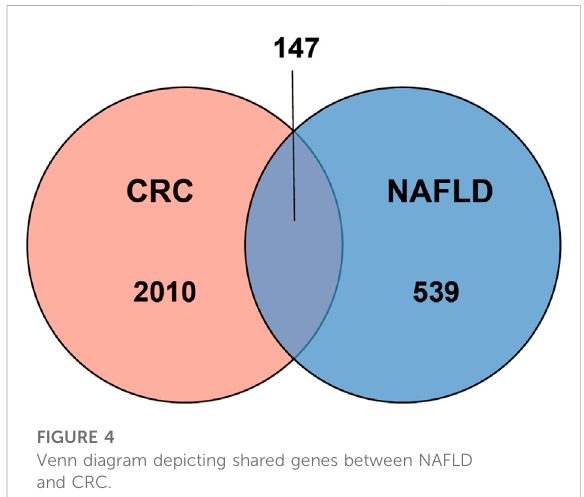
FIGURE 4 Venn diagram depicting shared genes between NAFLD and